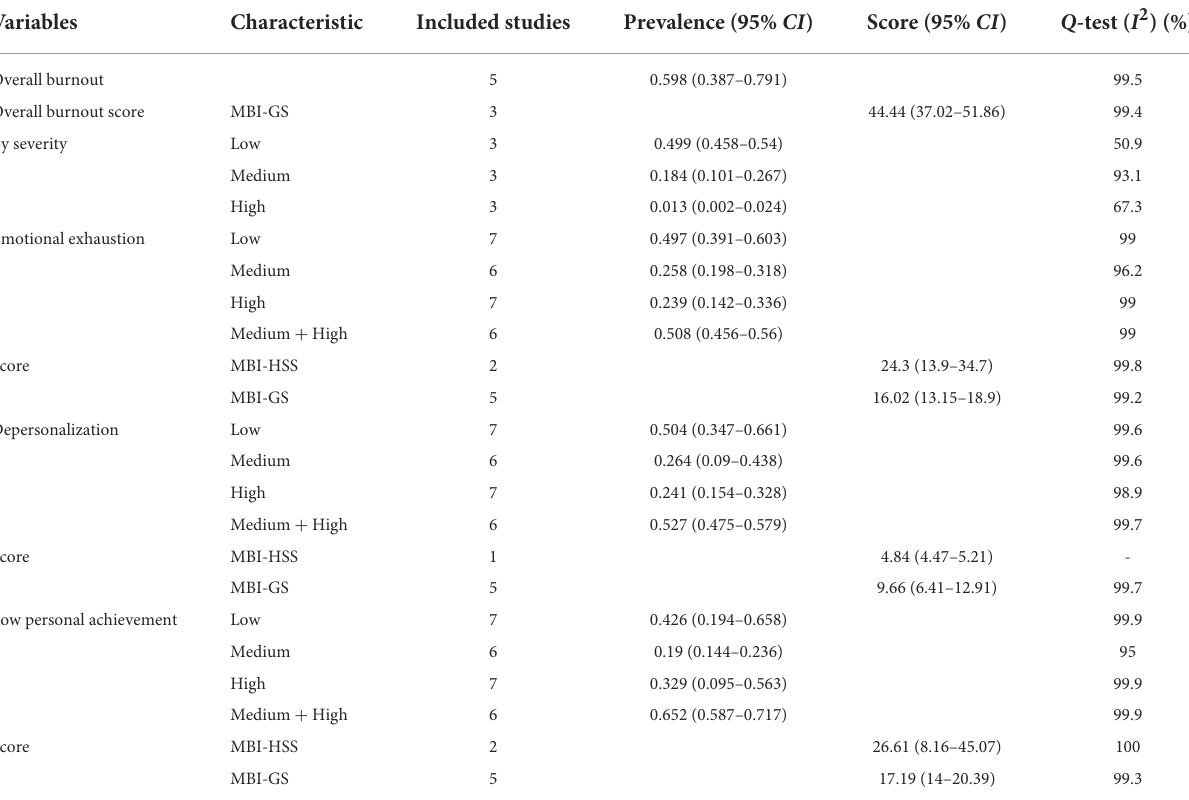
TABLE 6 Prevalence and score of job burnout and relevant dimensions among VDs in